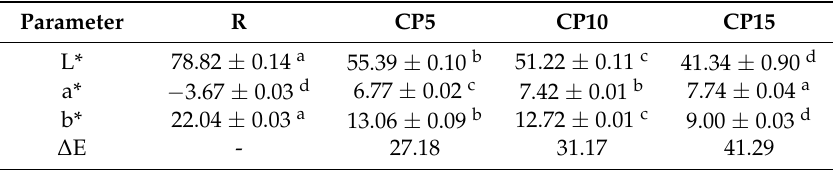
Table 2. Color parameters of analyzed pasta samples.